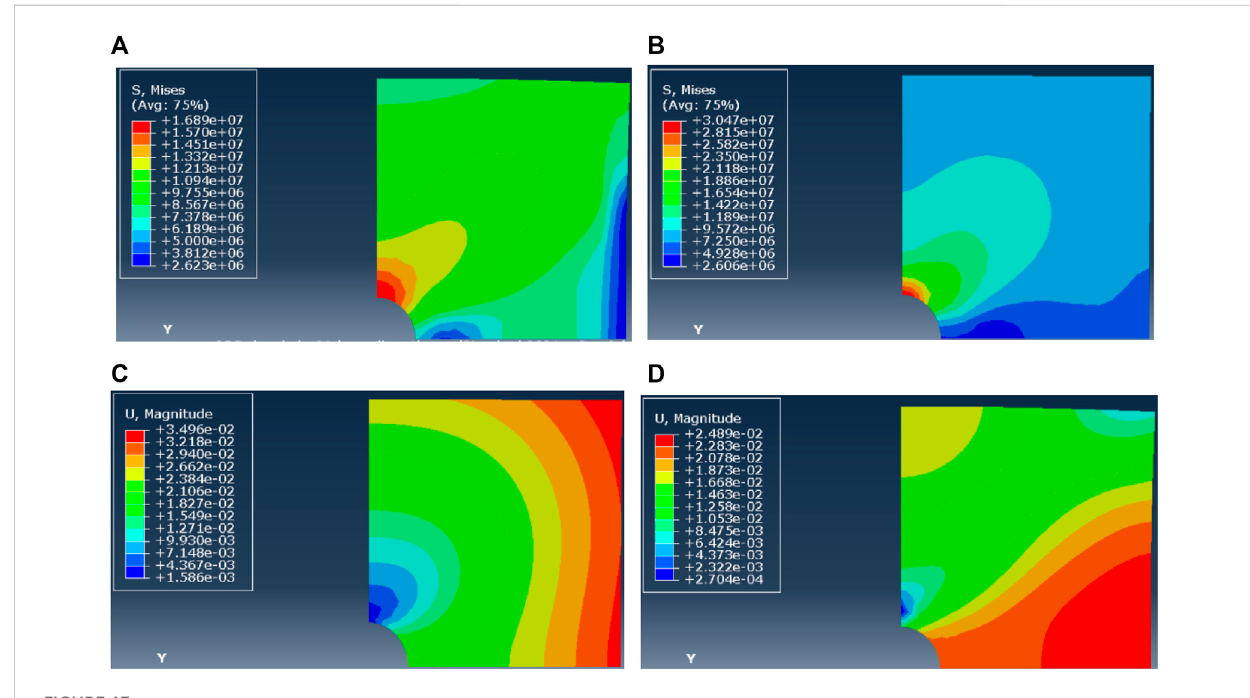
FIGURE 13 (A – D) Mises stressand displacement ofborehole shrinkage after reaming( Δ P= 10 MPa, n= 1).Misesstress anddisplacement ofborehole shrinkage after reaming ( Δ P = 10 MPa, n =